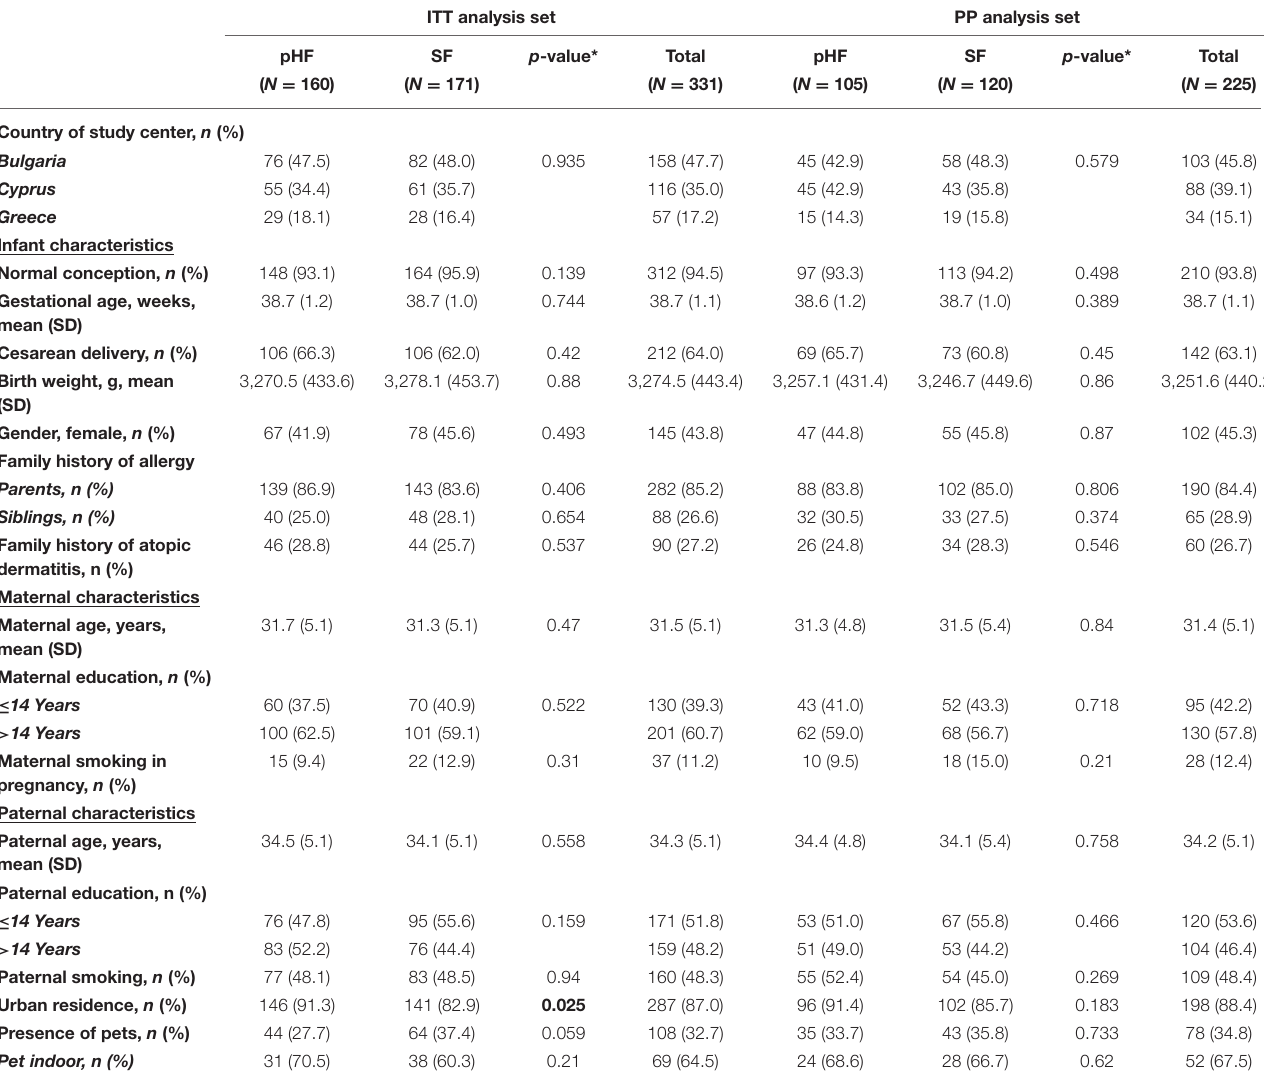
TABLE 1 | Baseline characteristics of study participants as in the ITT and PP analysis sets.